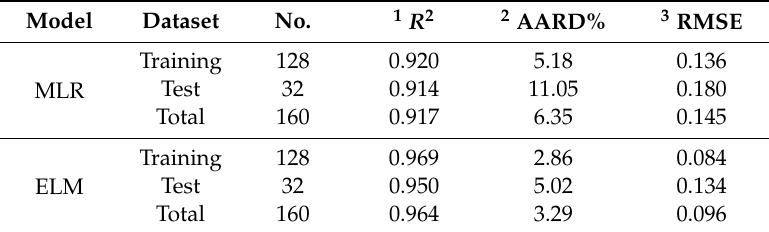
Table 2. Comparison of the statistical parameters by di ff erent quantitative structure-activity relationships (QSAR) models. Model Dataset No. 1 R